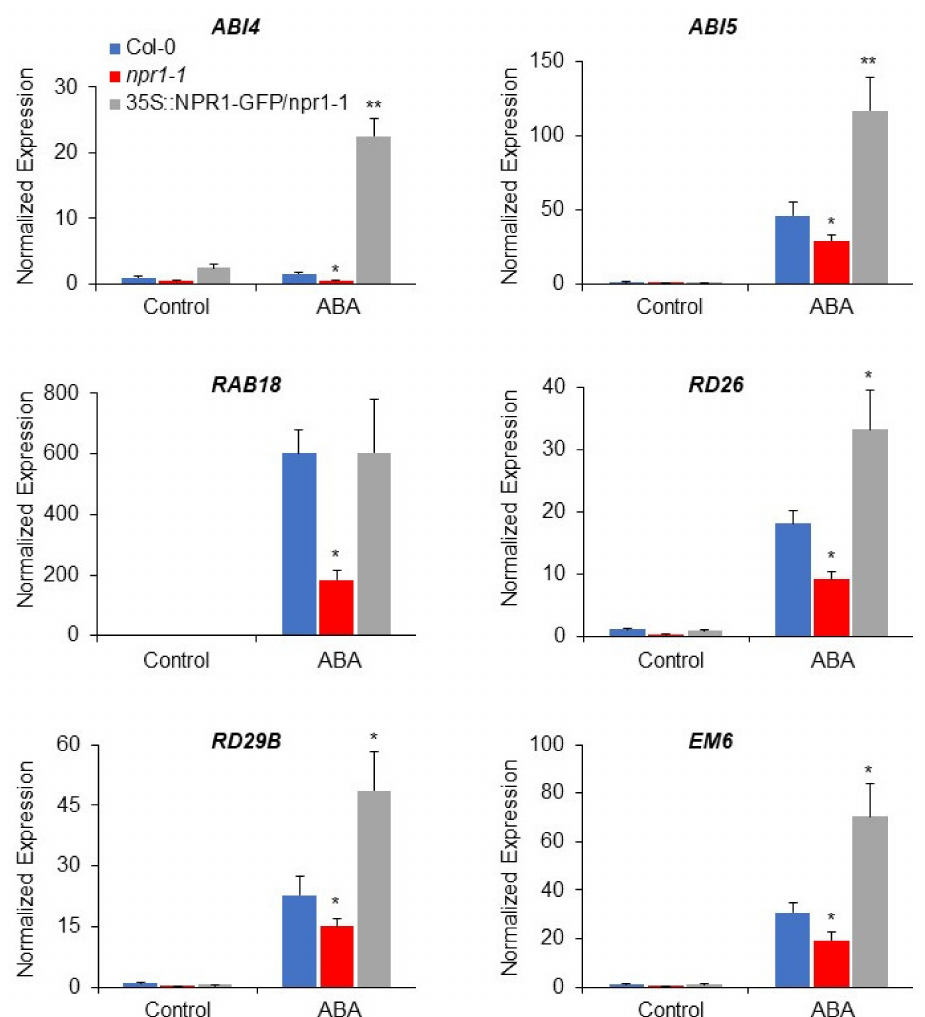
Figure 2. Expression analysis of downstream ABA-responsive genes in npr1-1 and 35S:NPR1- GFP / npr1-1. Relative mRNA level of ABA-responsive genes in the presence and absence of ABA in Col-0, npr1-1 , and 35S::NPR1-GFP / npr1-1 determined by qRT-PCR using total RNA extracted from 7-day-old seedlings treated without (Control) or with 100 µ M ABA for 6 h in MS liquid media. Ubiquitin was used as a control for normalization. The bars represent the mean ± standard error of three biological samples with technical replicates. Significant difference was determined by a student’s t -test with a p -value of <0.05 (*) or <0.01